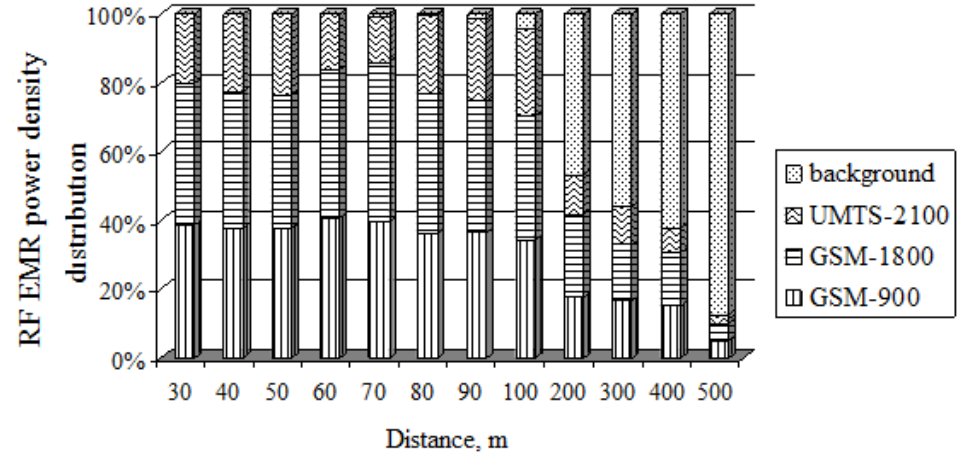
Figure 10. Contributions of different antenna types to the total exposure.